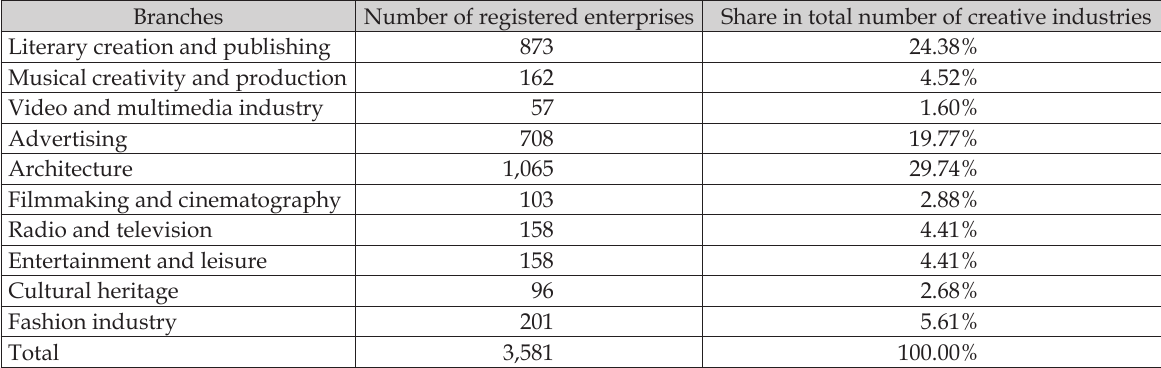
Table 1. Branches of the creative industry in Bosnia and Herzegovina, 2011.